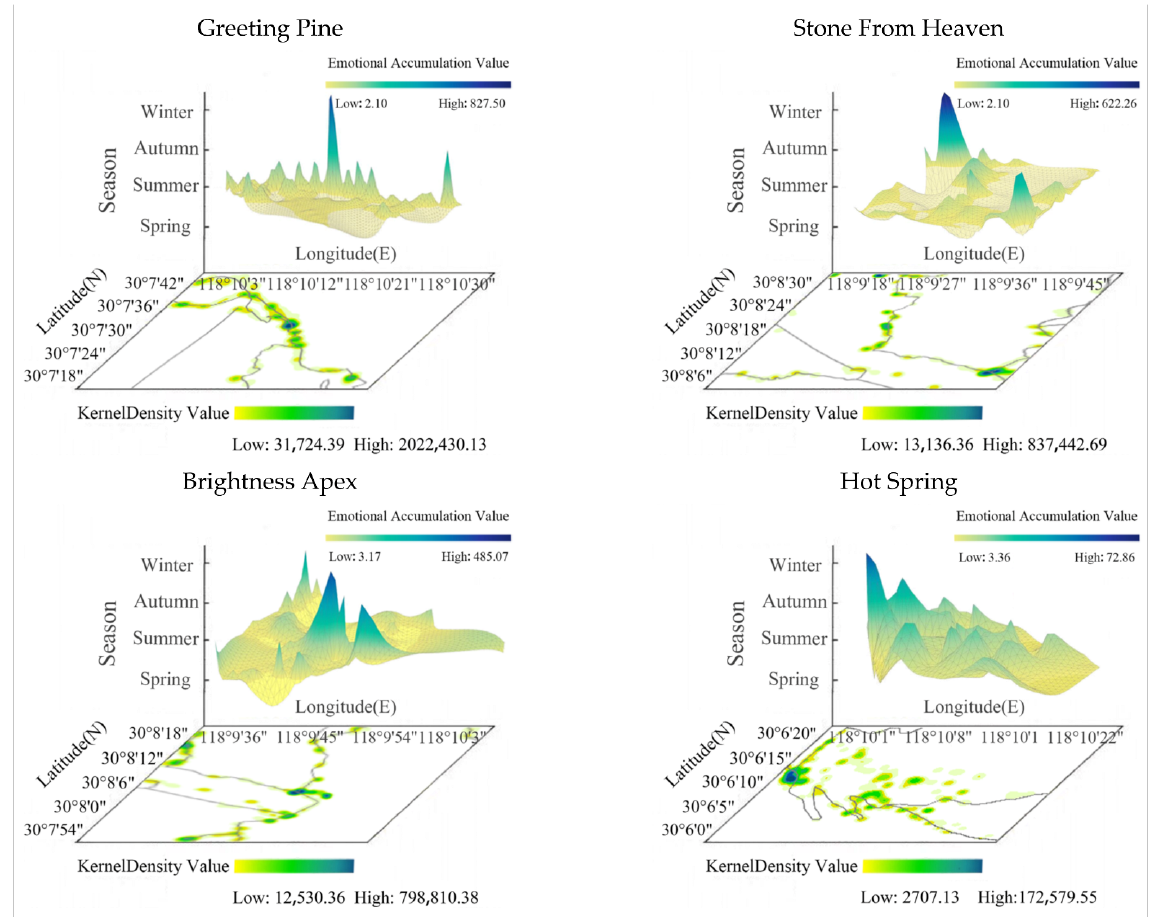
Figure 8. Popular tourist emotional value zones at Greeting Pine, Stone From Heaven, Brightness Apex, and Hot